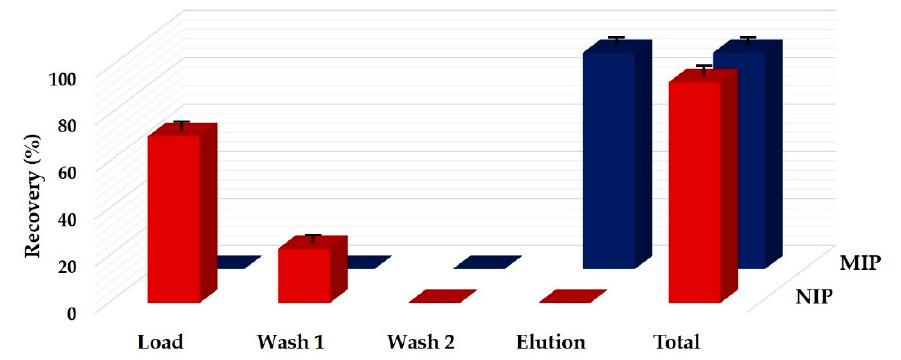
Figure 1. Recovery profile of zearalenone obtained on the non-imprinted polymer (NIP) and molecularly imprinted polymer (MIP) using pure solvent. Load: 3 mL of diethyl ether spiked with zearalenone at the level of 125 ng/mL; Wash 1: 6 mL of diethyl ether; Wash 2: 6 mL of water/acetic acid/acetonitrile (58:2:40 v/v/v ); Elution: 4 mL of methanol/acetic acid (98:2 v/v ).